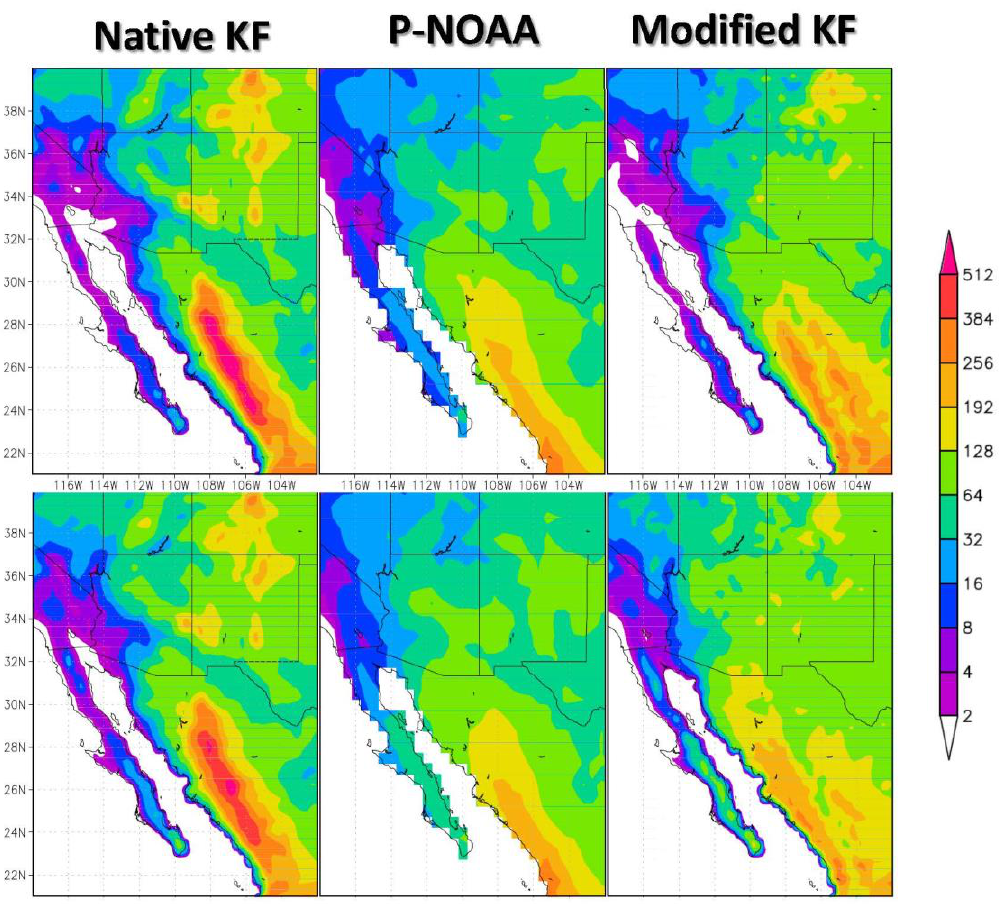
Figure 12. Monthly mean precipitation (mm month-1) averaged over 60-year (1951–2010) of July ( top ) and August ( bottom ) for WRF with native KF scheme ( left ), P-NOAA observation ( middle ), and WRF with modified KF scheme ( right ) on domain 1 (35 km grid spacing).